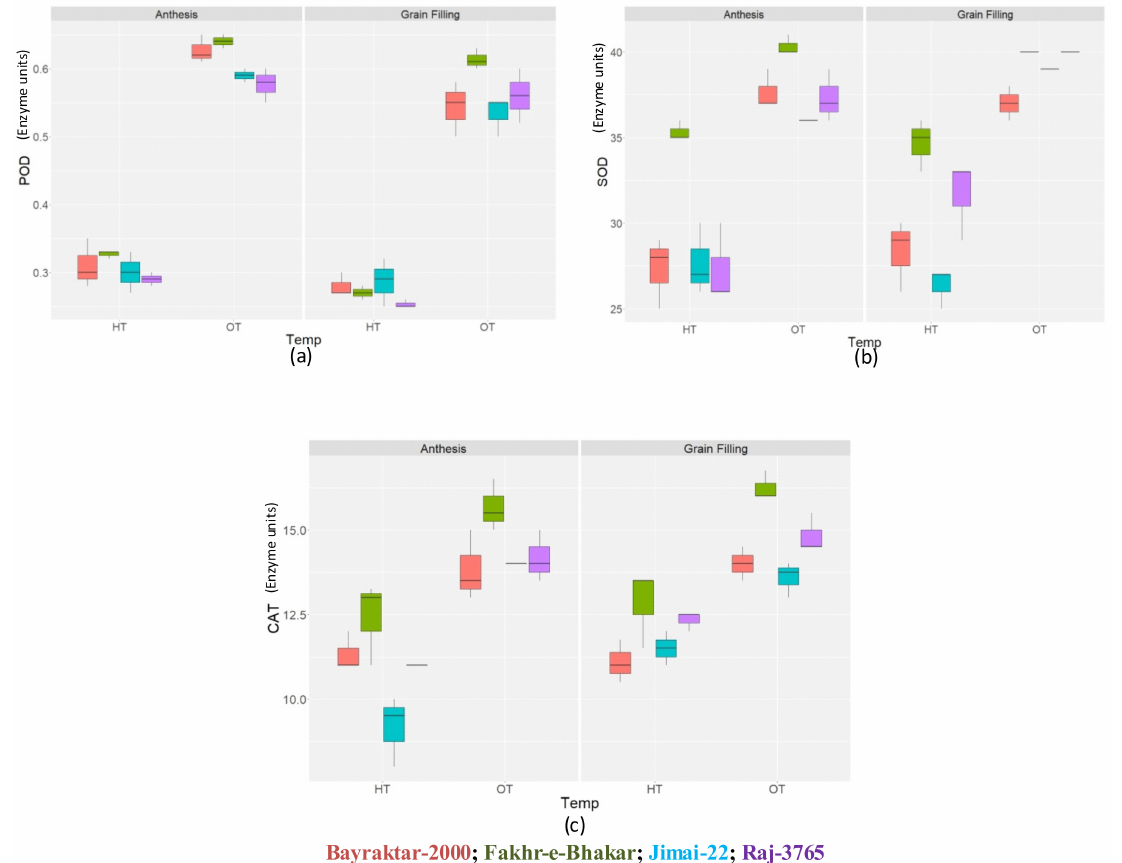
Figure 2. Effect of different regimes of temperature: optimum temperature (OT); high temperature (HT) on antioxidant enzymes of wheat genotypes during the grain-filling and anthesis stages. ( a ). POD, peroxidase; ( b ). SOD, superoxide dismutase; ( c ). CAT, catalase. Values shown are mean estimates averaged on 3, 5, 7, 9, 11 and 13 days of temperature treatment impositions during tri-replicate experiment at p ≤